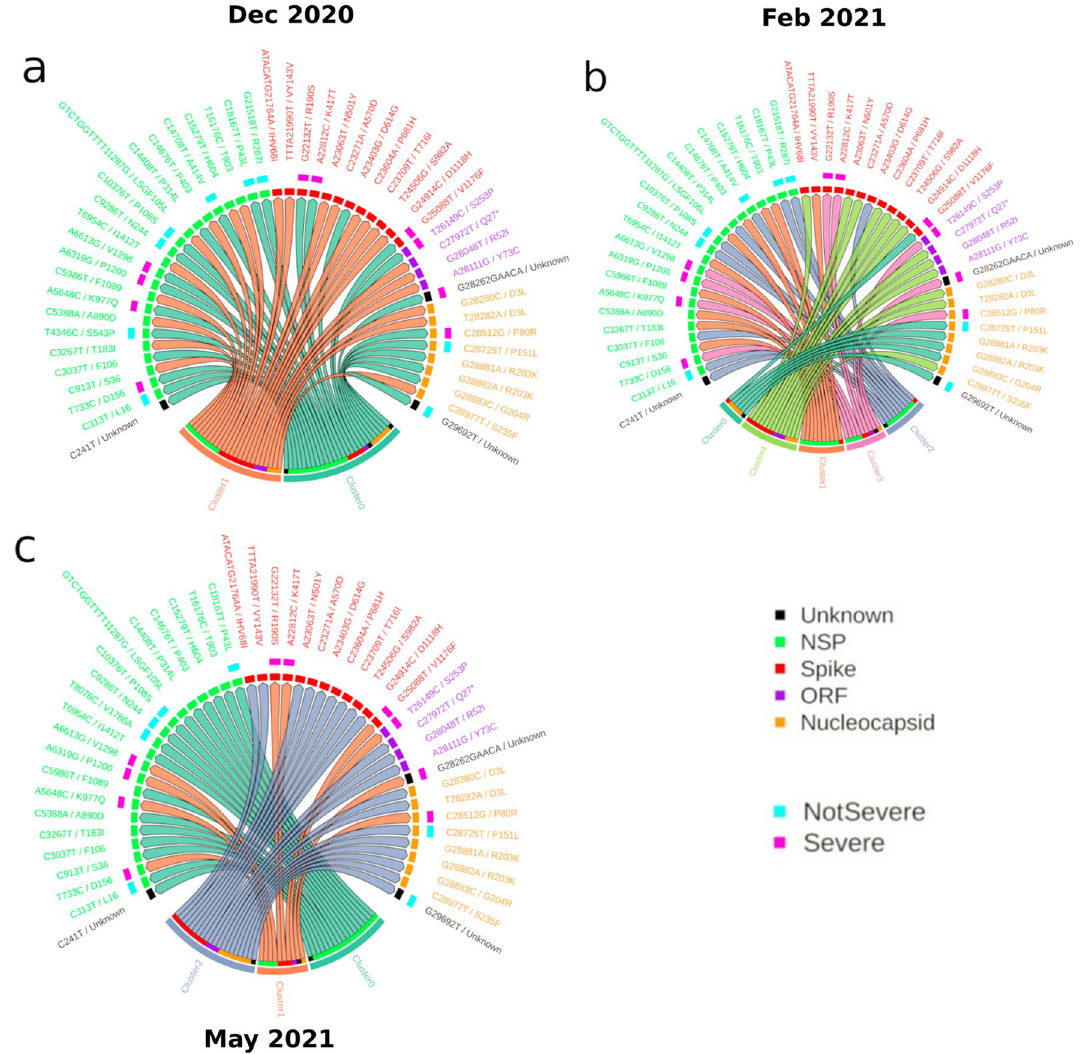
Figure 5. Semantic clustering of Severe, NotSevere and most frequent mutations. Panels ( a,b,c ) show chord diagrams of k-means clustering of 50 mutations (10 ‘Severe’, 10 ‘NotSevere’ and 30 most frequent mutations) in time-slices Dec2020, Feb2021 and May2021, respectively. Note that nucleotide mutations coloured in black (as Unknown) are on slices, their embeddings were ignored while plotting for the respective time-slices. Figure 5a–c depict chord diagrams highlighting mutations to the respective k-means cluster (refer Methods for further details). Sup- plementary Fig. 7a–c show 2D UMAP dimension reduction plots of the embedding vectors for the three time periods of these selected mutations. In Dec2020 (Fig. 5a and Supplementary Fig. 7a), the characteristic mutations of both patient health status categories (Severe and NotSevere) were observed to cluster into one group, and the majority of the most frequent mutations were found to be clubbed into another cluster. This indicated that the semantic differences were not very prominent between mutations of both patient health status categories. In contrast, segregation of mutations was observed into numerous clusters in Feb2021 (Fig. 5b and Supplementary Fig. 7b), wherein k-means clustering differentiated both Severe/NotSevere associated mutations into their respective clusters. However, for ‘NotSevere’ category mutations, the cluster set was not fully exclusive. Furthermore, the segregation of most frequent muta- tions into their respective protein of origin were found especially for NSP, spike and nucleocapsid proteins. In May2021 (shown in Fig. 5c and Supplementary Fig. 7c), the trend was however found to be contrasting. Unlike the subclusters seen in the Feb2021 time-slice, fewer cluster numbers were observed. In this timepoint, the NSP mutations from NotSevere category had coalesced into a separate cluster that comprised of NSP mutations from the neutral set. Cluster 1 was solely comprised of severe-category mutations. These inferences suggest that the ‘Severe’ and ‘NotSevere’ mutations are semantically different as well. The biological implications of the observa- tions have been further described in the ‘Discussion’ section.